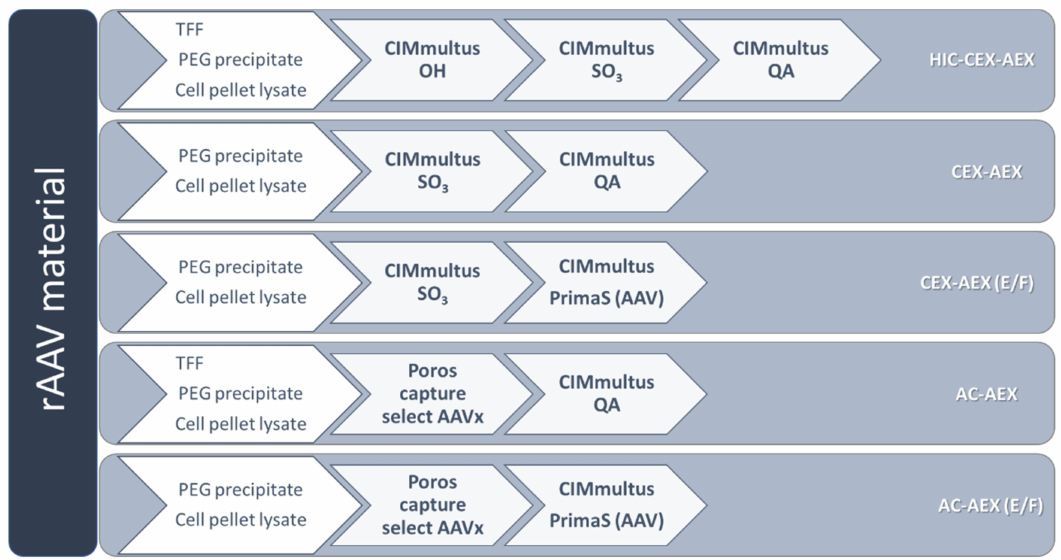
Figure 1. Overview of the five tested purification strategies to purify and to separate the empty and full recombinant adeno- associated virus (rAAV). For each experiment, only one harvesting method mentioned in the first arrow was performed.